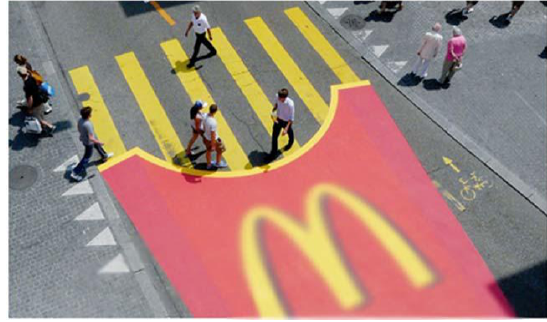
Figure 2. McDonald’s Pedestrian Crossing